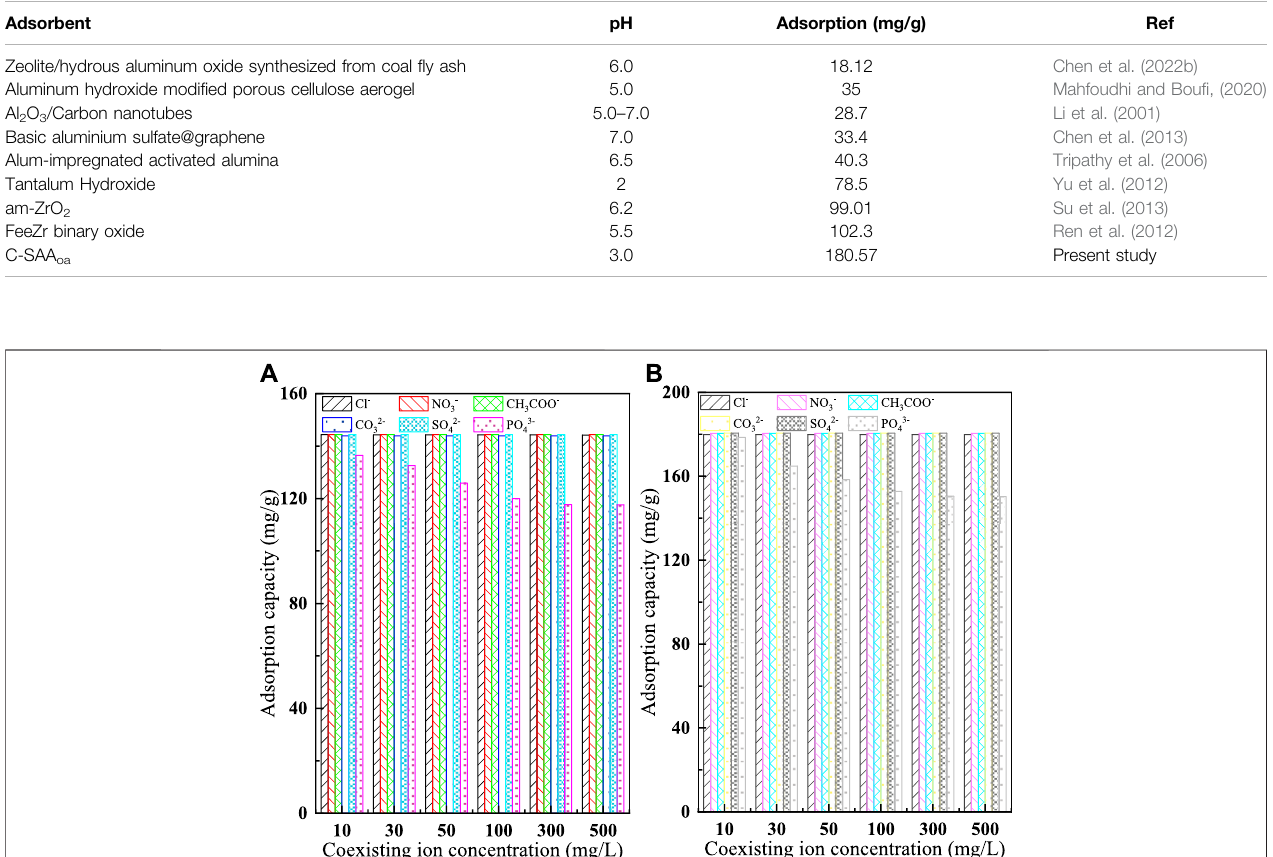
Frontiers in Environmental Science |